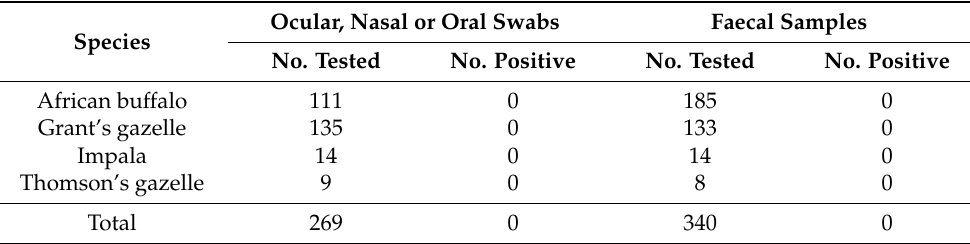
Table 4. Results of peste des petits ruminants virus (PPRV) real-time reverse transcription-polymerase chain reaction in wild animal samples by species during the cross-sectional survey in the Greater Serengeti ecosystem,